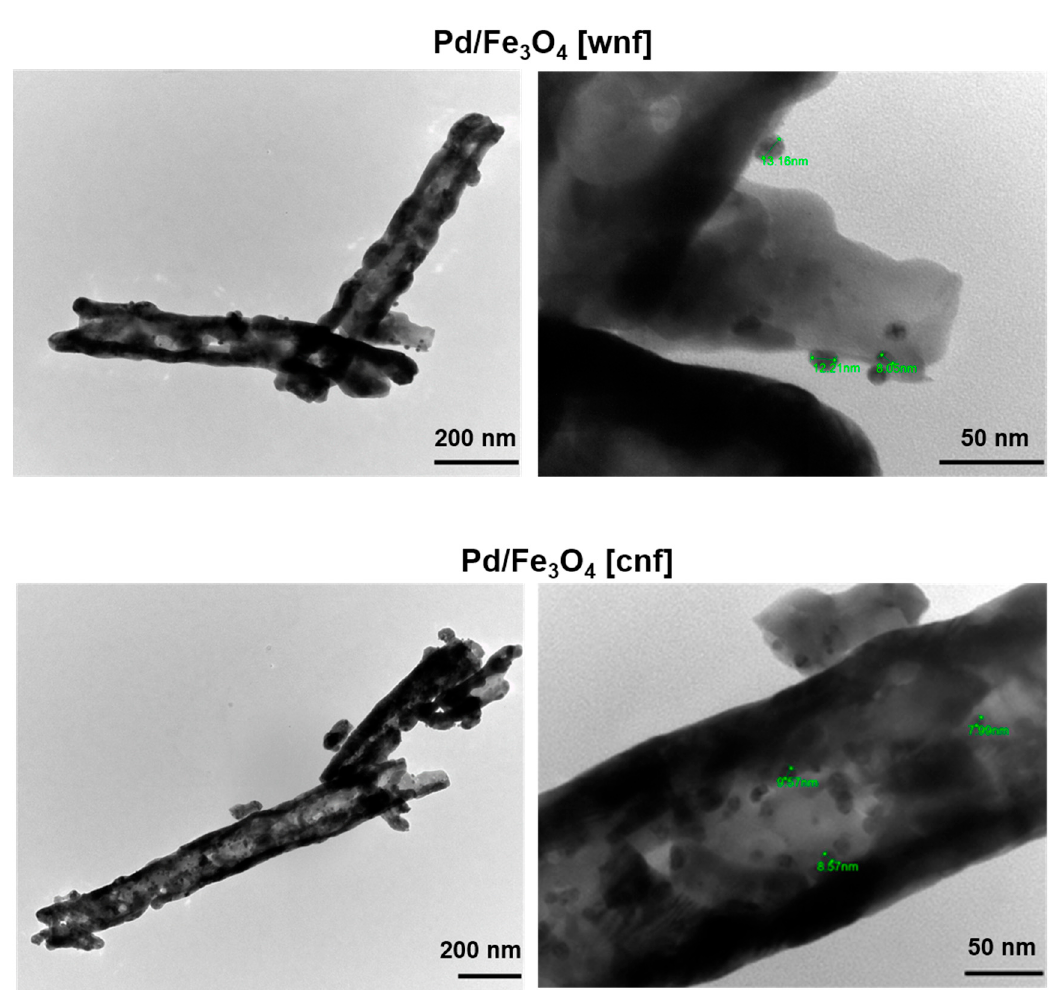
Figure 5. TEM images of samples Pd/Fe 3 O 4 [wnf] and Pd/Fe 3 O 4 [cnf] and relative Pd particle size dimensions.